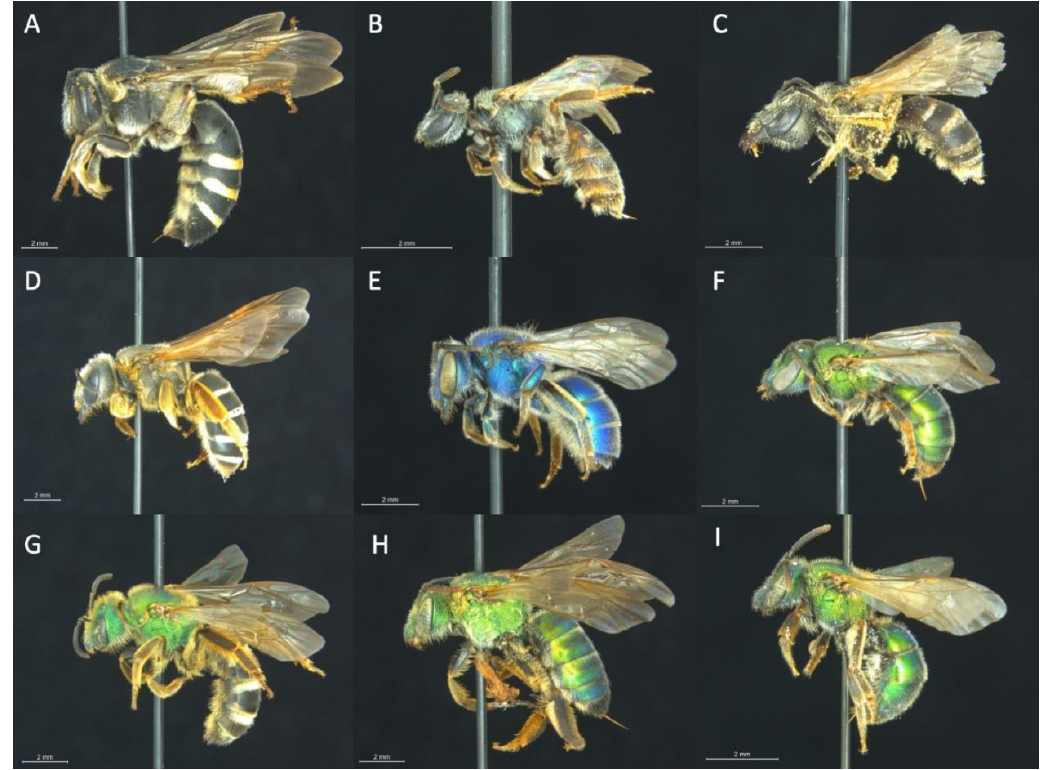
Figure 3. Some of the members of the family Halictidae observed in cotton fields: ( A ) Nomia (Acunomia) nortoni ; ( B ) Lasioglossum (Dialictus) spp.; ( C ) Halictus (Odontalictus) ligatus ; ( D ) Halictus (Nealictus) parallelus ; ( E ) Augochloropsis metallica ; ( F ) Augochlorella aurata ; ( G ) Agapostemon virescens ; ( H ) Agapostemon splendens ; ( I ) Augochlora pura pura.